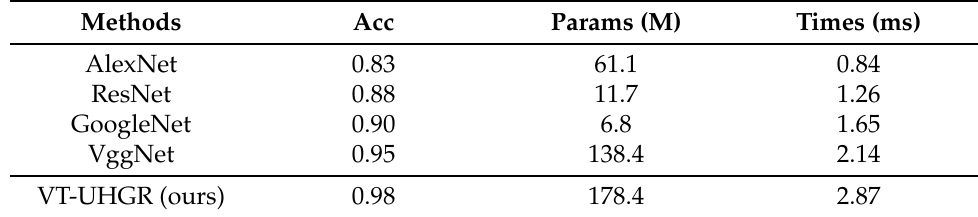
Table 1. Quantitative comparison of end-to-end methods on the CADDY dataset.